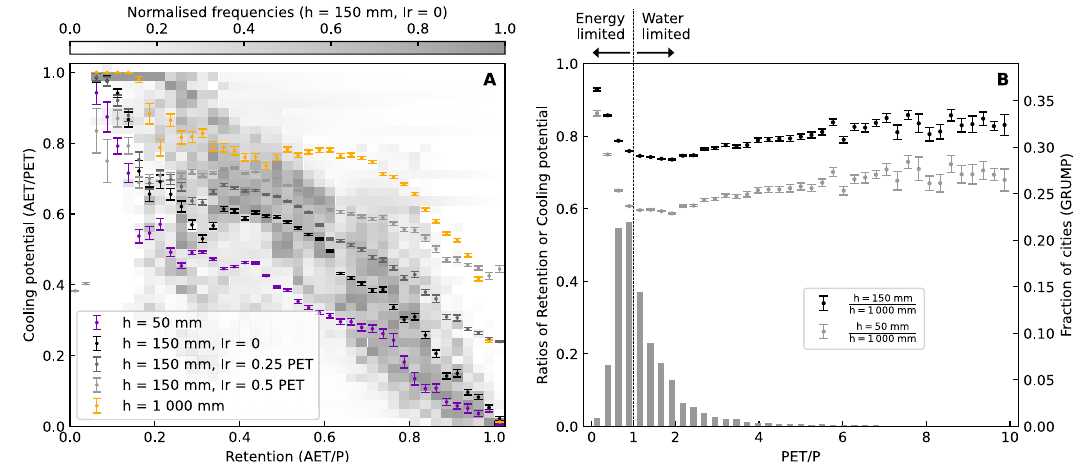
Fig. 3 Summary of the trade-offs between mean retention and cooling for different types of urban greening. ( A ) Trade-offs between retention and cooling potential for different substrate thicknesses ( h ) and irrigation ( Ir ) applications. Points are means + / − standard error of the mean (SEM), shadings represent the binned and normalized frequency values for the intensive unirrigated substrate. ( B ) Histogram of global cities binned by PET/P alongside the fraction of retention or cooling potential offered by intensive substrate ( h = 150 mm) and extensive substrate ( h = 50 mm) as a fraction of the deep substrate ( h = 1000 mm). The ratio of retention and cooling potential metrics is identical as both are equivalent to the ratio of AET between the respective substrate types. Values plotted as means + /-